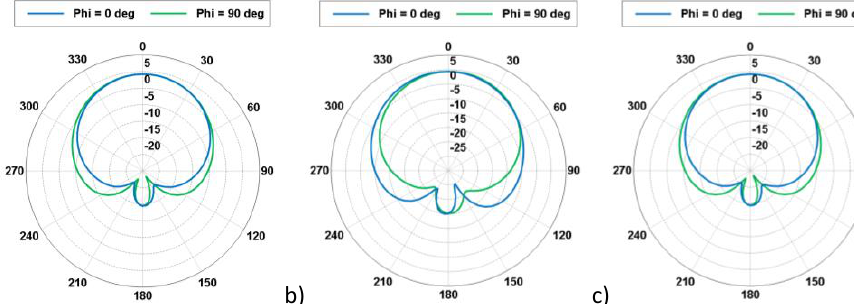
Fig. 3. Radiation patterns of single radiator in polar coordinates at frequencies of 4.75 GHz (a), 5 GHz (b) and 5.25 GHz (c).